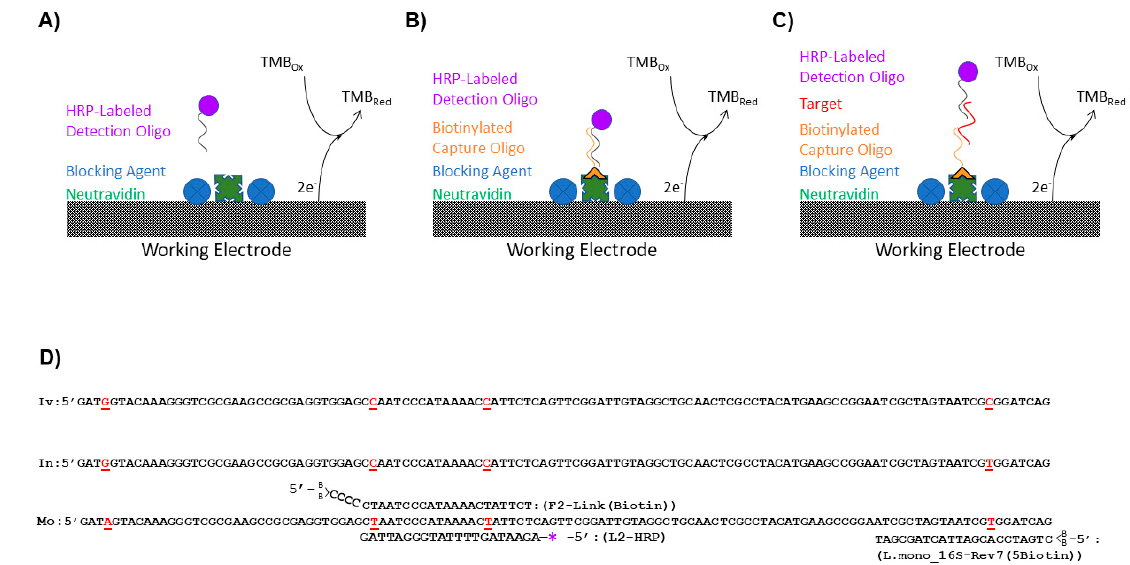
Figure 1. Design of the enzyme-amplified electrochemical biosensor using oligos. ( A – C ) Schematic of the different GFE surfaces utilized, with signal generation ultimately relying upon the presence of the HRP-conjugated oligo to facilitate oxidation of the TMB substrate. ( A ) The GFE surface utilized to assess blocking performance. Negative sample preparations assessed aspecific oligo adsorption and positive sample preparations defined the maximum signal intensity. ( B ) The GFE surface utilized for sensor development. The capture oligo binds directly to the detection oligo since it is complementary in sequence. ( C ) The GFE surface utilized for the detection of L. monocytogenes . The 16S rDNA sequence from L. monocytogenes serves as a bridge binding both the capture oligo and the detection oligo. ( D ) A nucleotide alignment of the 16S rDNA region from L. ivanovii (Iv), L. innocua (In), and L. monocytogenes (Mo). Nucleotides that differed amongst the species are denoted by bold red letters that are underlined. Oligos utilized and their modifications are also shown. The * denotes modification with HRP whereas the < B denotes a dual biotin B